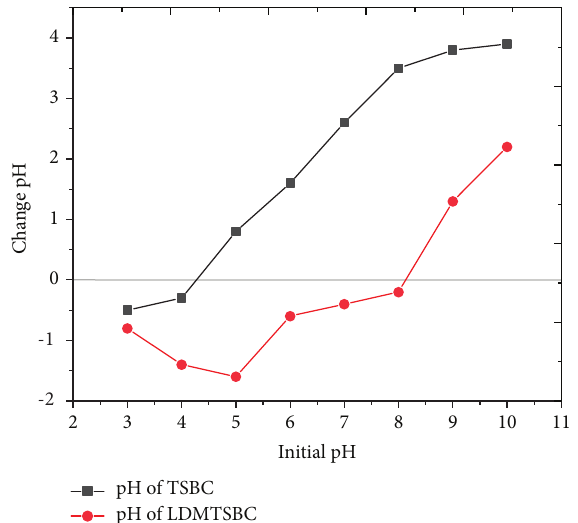
Figure 1: Point zero charge determination for TSBC and LDMTSB.